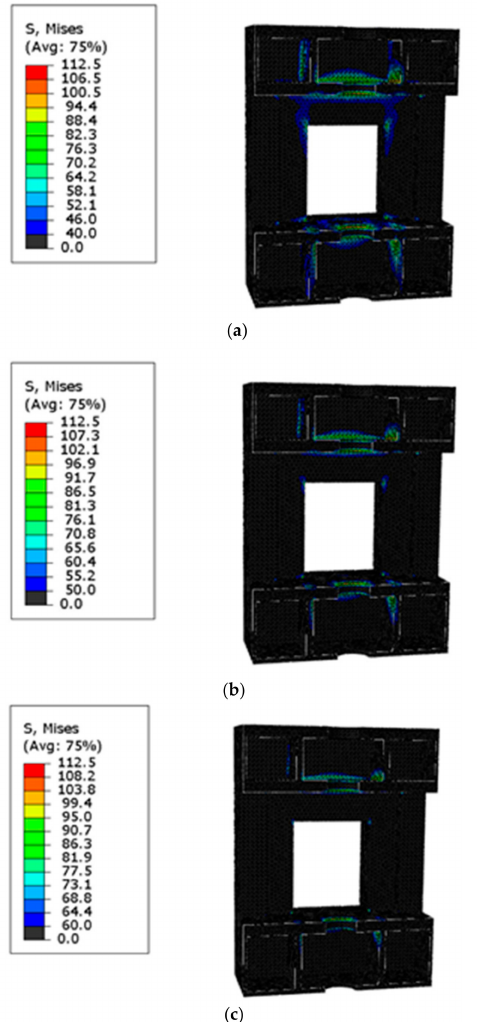
Figure 5. Positions where the equivalent stress is more than 40 MPa ( a ), 50 MPa ( b ) and 60 MPa ( c